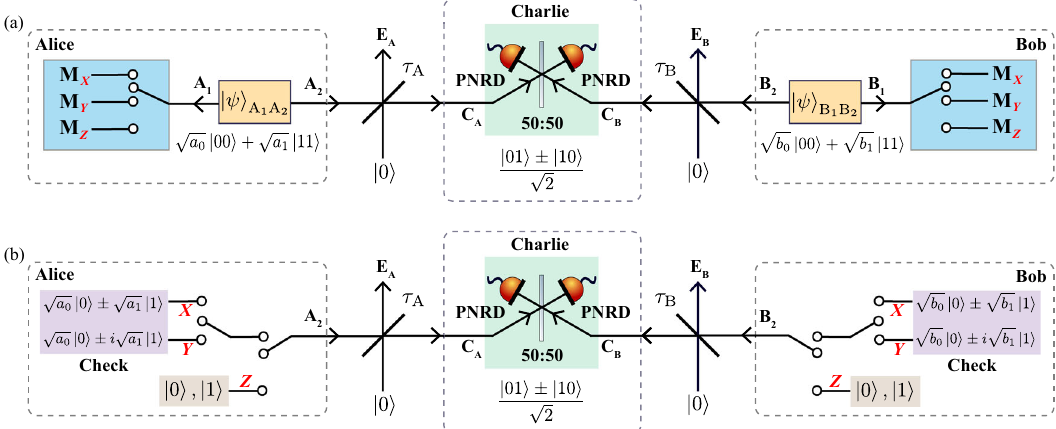
Fig. 5 Equivalent representations of the protocol with single photons. a Entanglement-based scheme where both Alice and Bob send the optimised states in the form